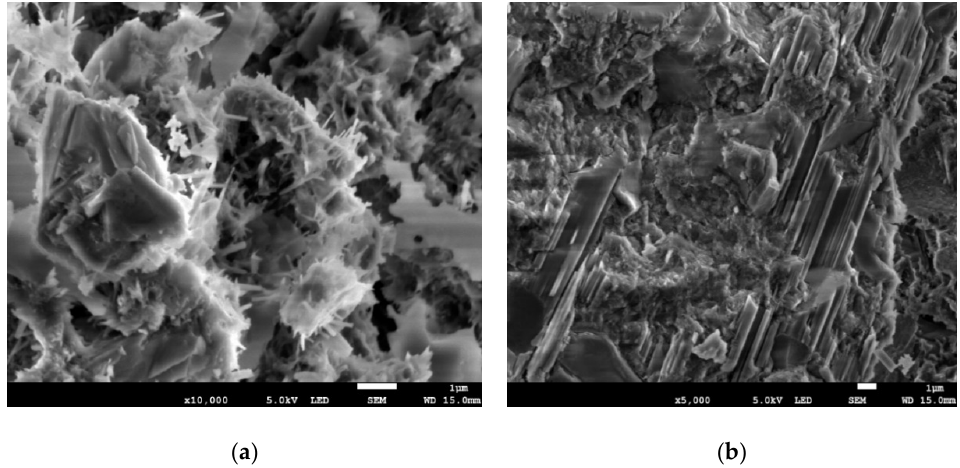
Figure 6. SEM images of the samples taken from center layer of the concrete structure: ( a ) ×10,000; ( b ) ×5000.